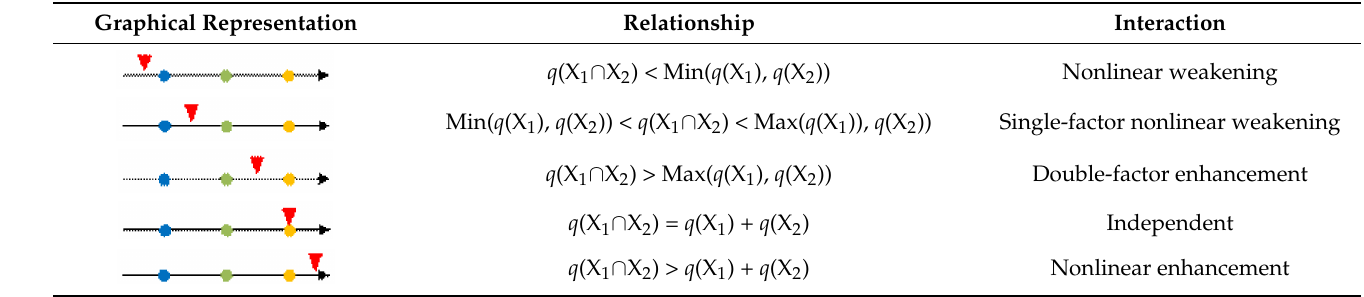
Table 2. Types of interaction between two